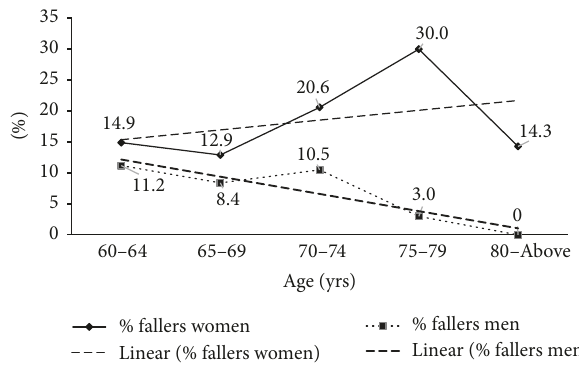
Table 3: Logistic regression predicting odds of having fallen in the past year by risk factors among Women.